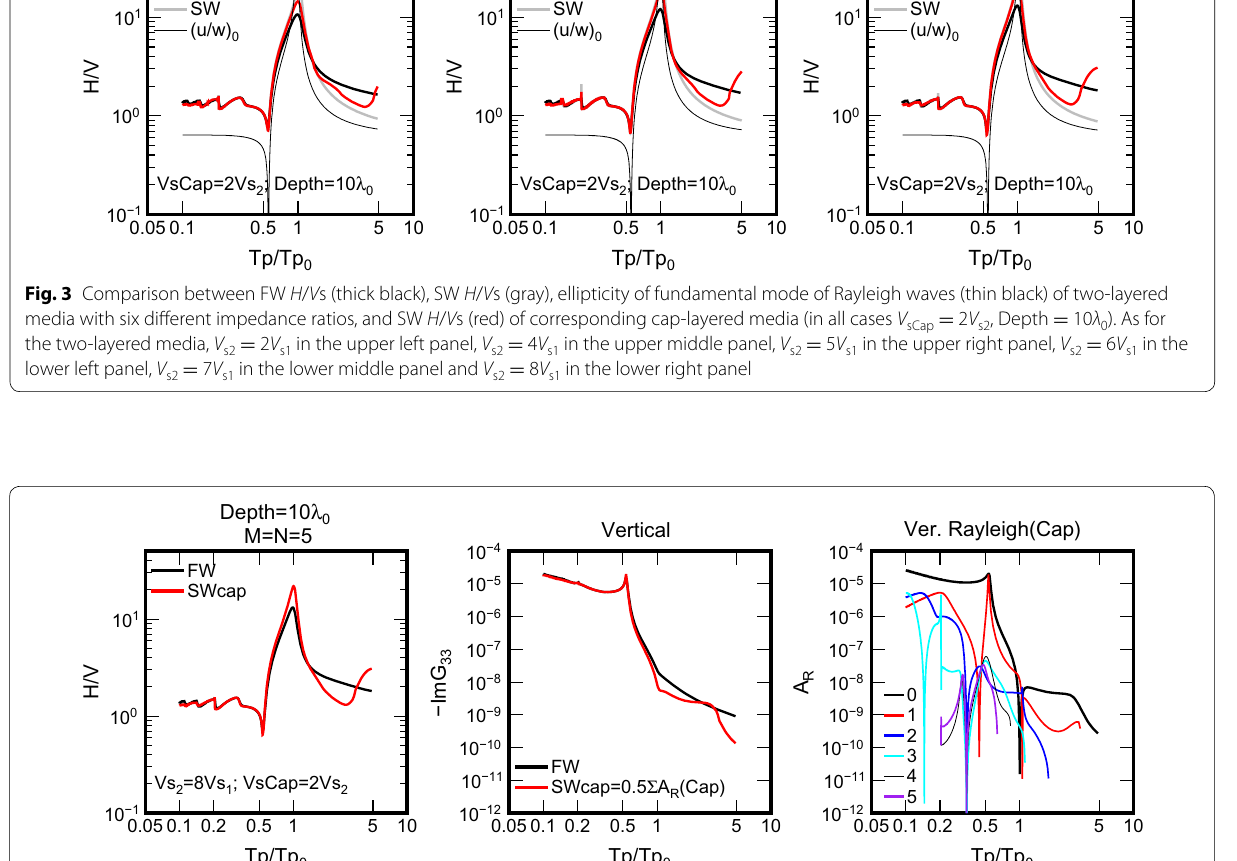
8 V s1 ), and SW H / V (red) for cap‑layered medium =